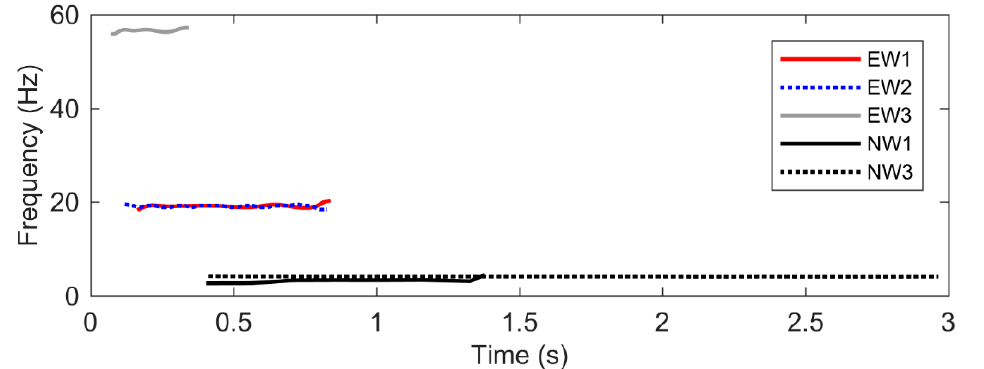
Figure 14. Time series of frequency.